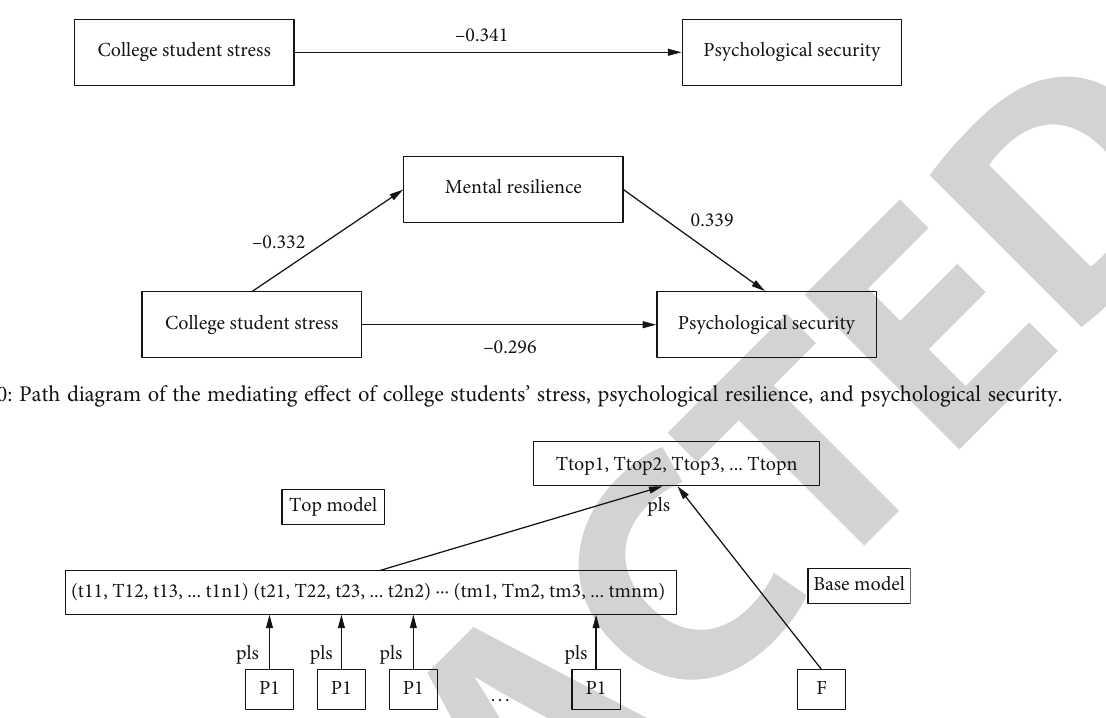
Figure 11: Schematic diagram of Hi-PLS regression